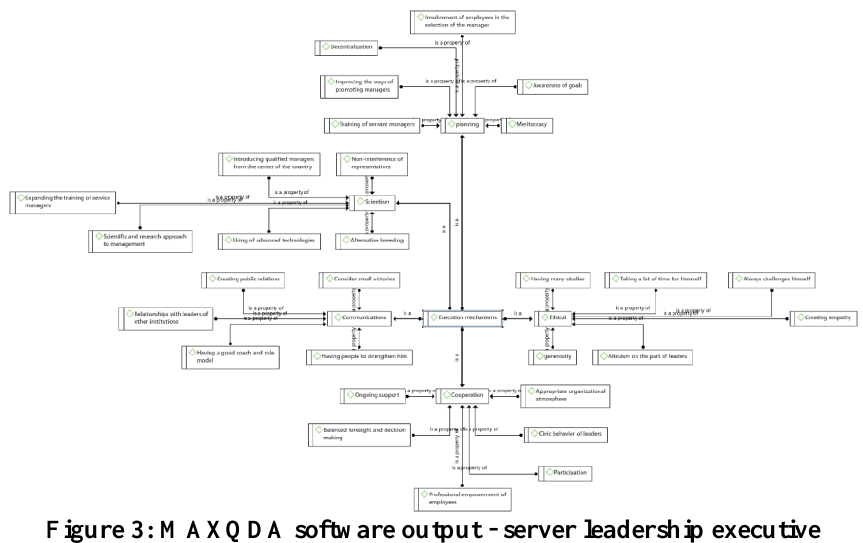
Figure 3: MAXQDA software output - server leadership executive mechanisms